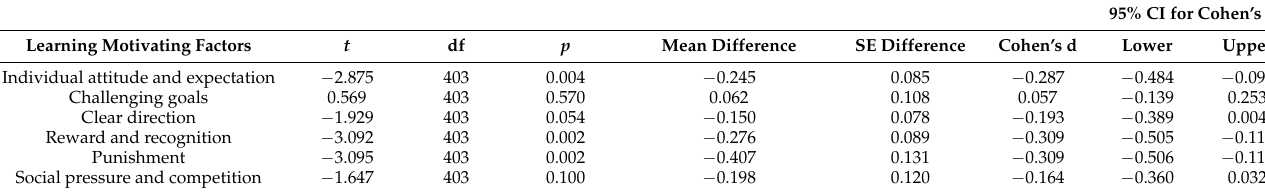
Table 6. Differences in learning motivating factors between the groups of participants and non-participants of e-learning based computer programming courses.